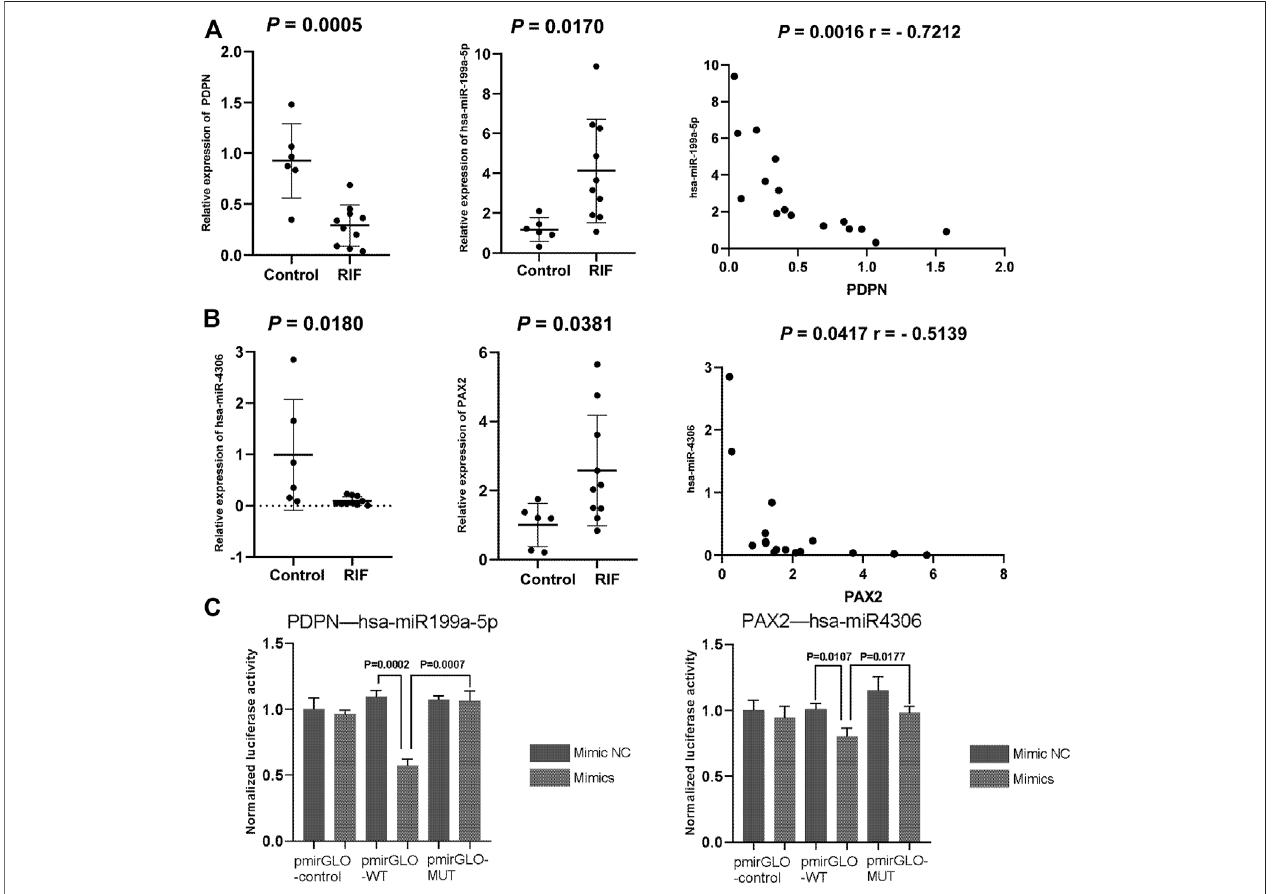
FIGURE 9 | (A,B) Quantitative PCR validation of miRNAs and mRNAs in the control group and RIF group. The expression of (A) PDPN and hsa-miR-199a-5p and (B) PAX2 and hsa-miR-4306. (C) Dual-luciferase assay validation of target relationship of miRNA and genes. Data are presented as the normalized fold change. Experiments were repeated in triplicate, and values are expressed as mean ± SEM. * tive. A; miRNA or miR,